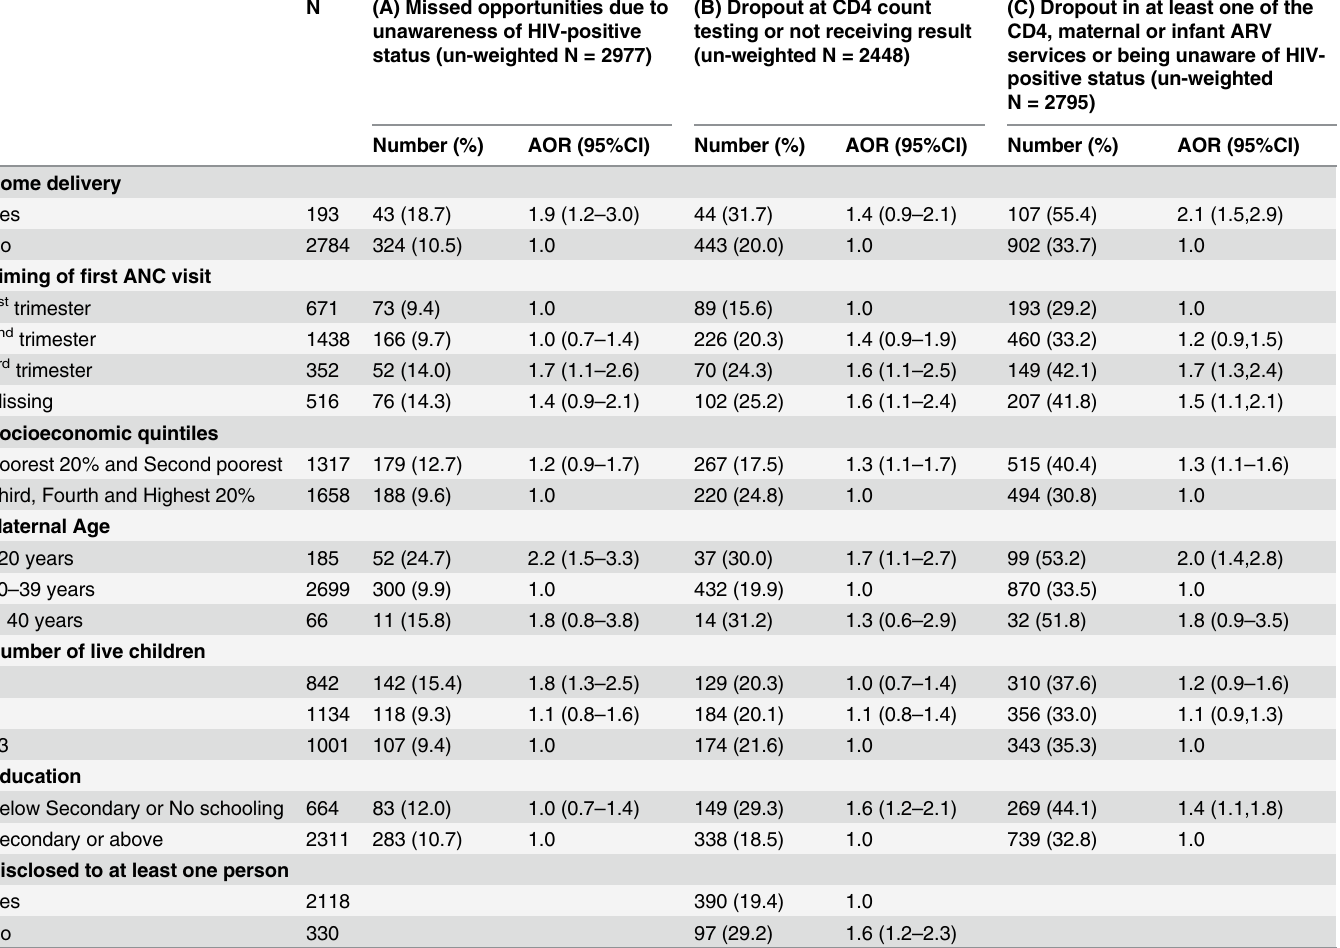
Table 3. Factors associated with dropout at the stage of maternal HIV testing (A), CD4 count testing and result (B) and at any of the four steps in the PMTCT cascade(C), 2010 (logistic model). N (A) Missed opportunities due to (B) Dropout at CD4 count (C) Dropout in at least one of the unawareness of HIV-positive testing or not receiving result CD4, maternal or infant status (un-weighted N = 2977)